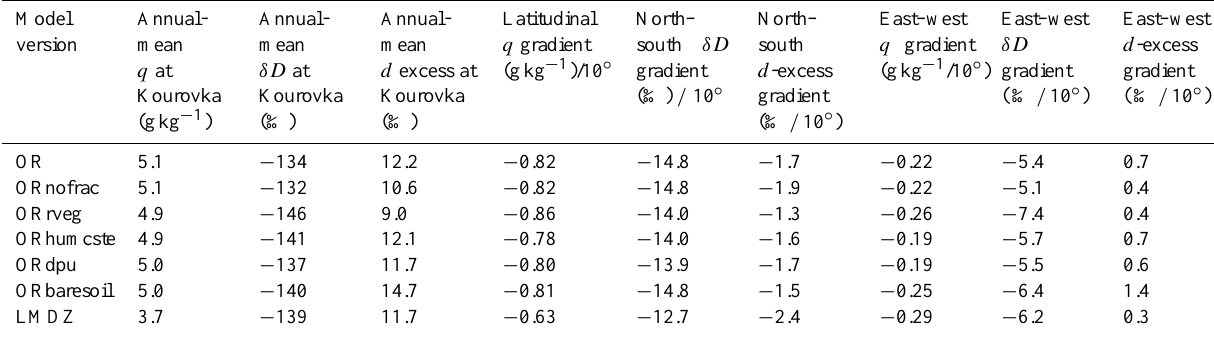
Table 4. Characteristics of the spatial distribution in q , δD and in d excess of near-surface vapor, for the LMDZ simulation and for the different LMDZ-ORCHIDEE sensitivity tests listed in Table 1. At Kourovka, we calculate an average in the 52–62 ◦ , 55–65 ◦ E domain. The latitudinal gradient is quantified as the difference between the average in the 30–40 ◦ N, 55–65 ◦ E domain and in the 70–80 ◦ N, 55–65 ◦ E domain. The longitudinal gradient is quantified as the difference between the average in the 52–62 ◦ N, 20–30 ◦ E domain and in the 52–62 ◦ N, 110–120 ◦ E